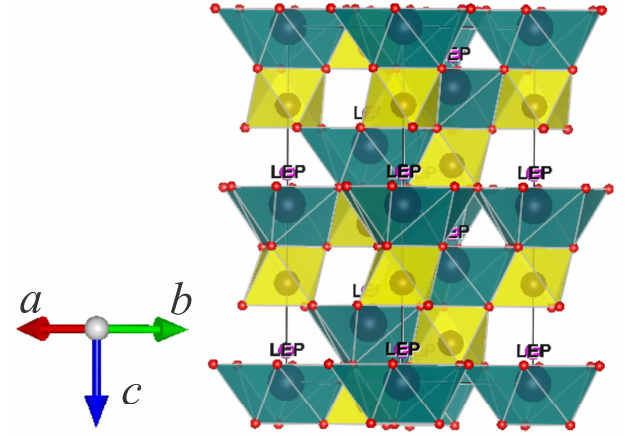
Minerals 2021 , 11 , x Figure 2. Polyhedral presentation of the BiFeO 3 crystal structure. Figure 2. Polyhedral presentation of the BiFeO 3 crystal structure.